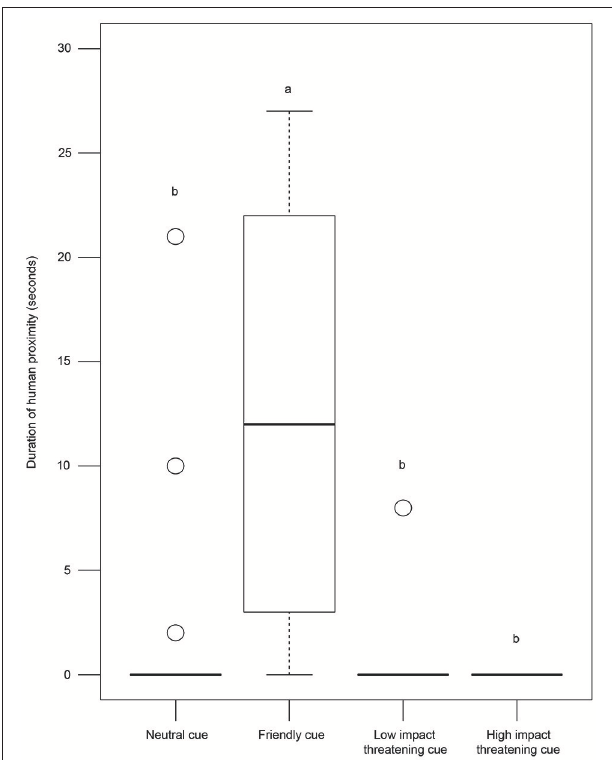
FIGURE 5 | Duration of human proximity. Box and whisker plot illustrating the duration of human proximity of dogs in SCP of NC, FC, LIT, and HIT conditions. Dogs showed significantly higher proximity to E1 in the FC (12.43 ± 9.54 sec) than in other conditions. Boxes represent interquartile range, horizontal bars within boxes indicate median values, and whiskers represent the upper range of the data. “a” and “b” indicate significant differences.